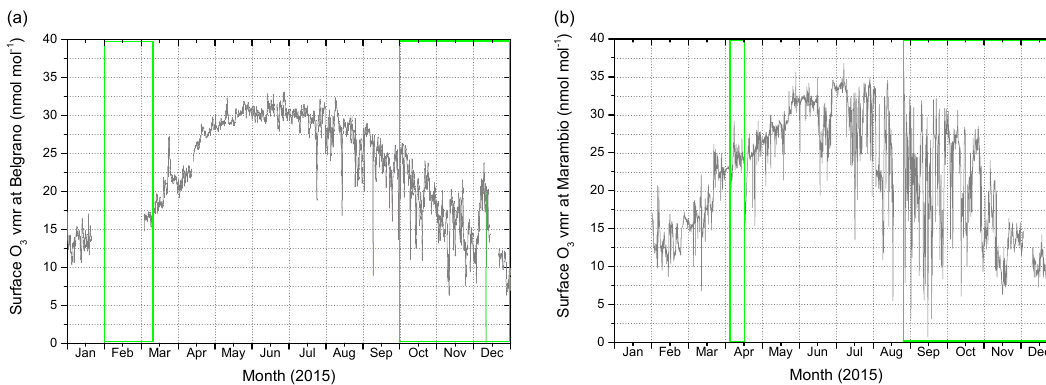
Figure 6. The 2015 near-surface ozone observations at the Belgrano (a) and Marambio (b) research stations. Note the same vertical scale in both plots. Both data sets were gathered by in situ O 3 observations made by INTA (at Belgrano) and by the Argentinian Meteorological Service (at Marambio). The periods with MAX-DOAS data (SZA<75 ◦ ) at each station are contained within the green